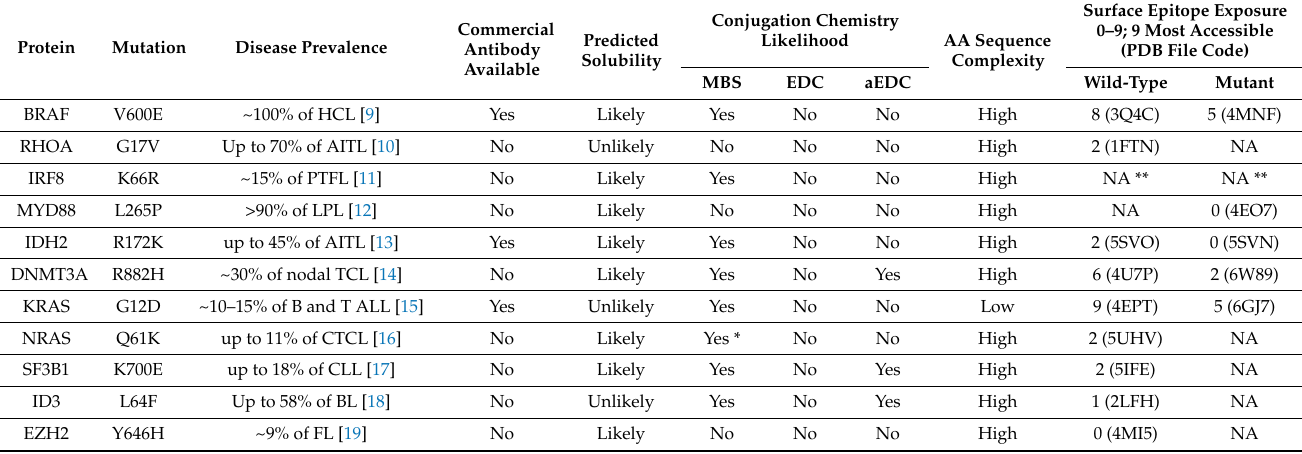
AITL = angioimmunoblastic T-cell lymphoma; HCL = Hairy cell leukemia; PTFL = Pediatric-type Follicular Lymphoma; CTCL = Cutaneous T-cell lymphoma; ALL = Acute Lymphoblastic Leukemia; CLL = Chronic Lymphocytic Leukemia; BL = Burkitt’s lymphoma; FL = Follicular lymphoma. * The 21-mer used for the NRAS mutation contains a cysteine residue at the N-terminus, which is predicted to be conju- gatable with MBS. MBS = m-Maleimidobenzoyl-N-hydroxysuccinimide ester; EDC = 1-ethyl-3-[3-dimethylaminopropyl]carbodiimide hydrochloride; aEDC = activated EDC. ** The surface epitope exposure for IRF8 is unknown due the unavailability of a 3D structure from RCSB